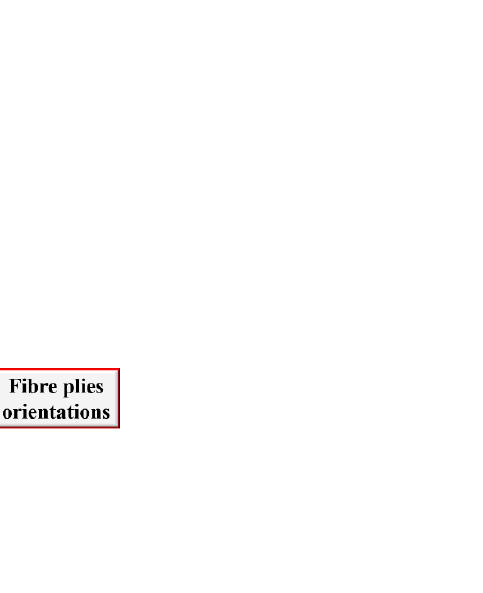
Figure 1. Multidirectional CFRP workpiece with micrograph of cross-section showing lay-up orien- tation of the plies [24,25]. Table 1. Key physical/mechanical properties of the post cure CFRP laminates [24,25].